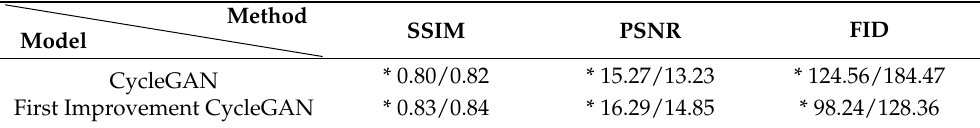
Figure 14. Image translation results with resolutions of 512 × 512 and 256 × 256. ( a ) Input laser image. ( b ) Image of 256 × 256 resolution using CycleGAN. ( c ) Image of 256 × 256 resolution using first improved CycleGAN. ( d ) Image of 512 × 512 resolution using CycleGAN. ( e ) Image of 512 × 512 resolution using first improved CycleGAN. ( f ) Ground truths. Table 6. Compare image translation quality at different